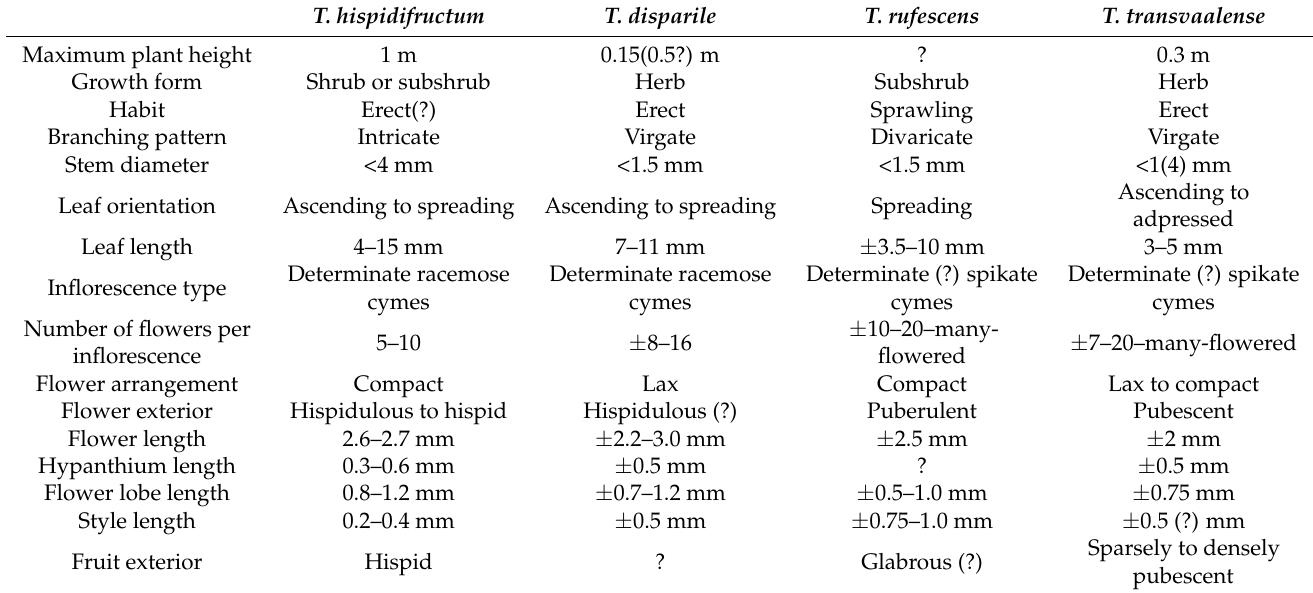
Table 2. A comparison of the main diagnostic characters to distinguish among Thesium hispidifructum and three morphologically similar species, T. disparile , T. rufescens , and T. transvaalense . Missing data are indicated with “?” and uncertain data with